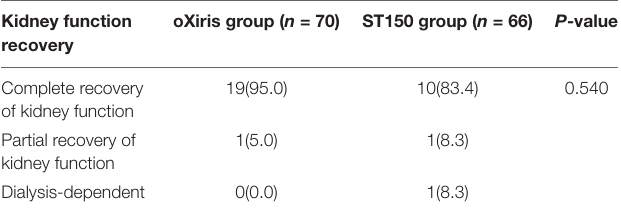
TABLE 5 | The prognosis of kidney function. TABLE 6 | Cox regression analysis of variables associated with 90-day outcomes of